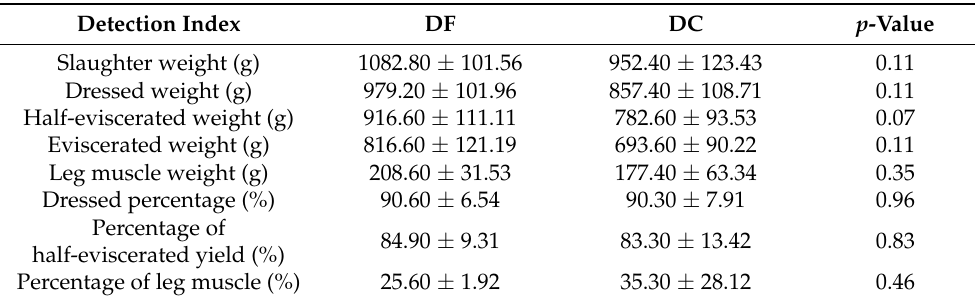
Table 3. Determination of slaughter performance of